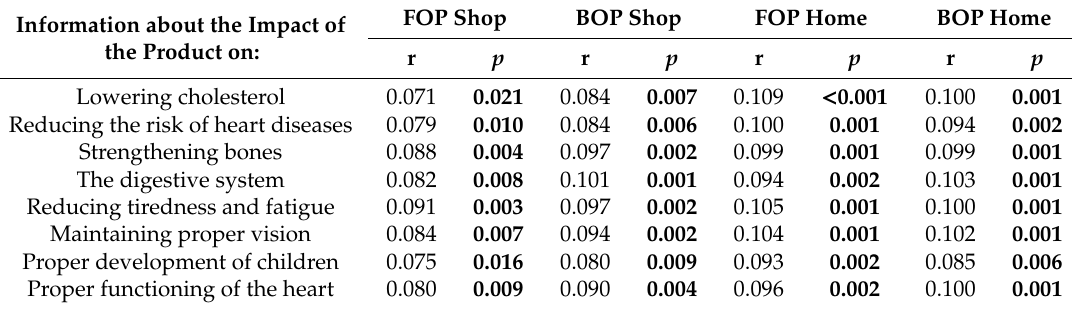
Table 15. Pearson correlation coe ffi cients of reading food labels with the subjective importance of selected health information on